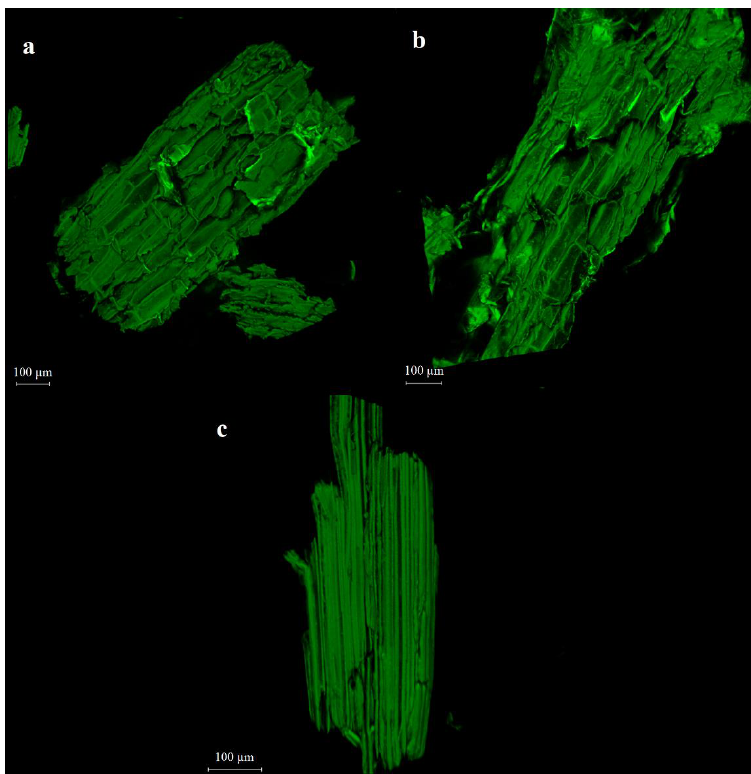
Figure 6. Confocal laser scanning microscopy image of SCB (710 µm particle size) for ( a ) unpretreated SCB, ( b ) pretreated SCB and ( c ) pretreated enzymatically hydrolyzed SCB.